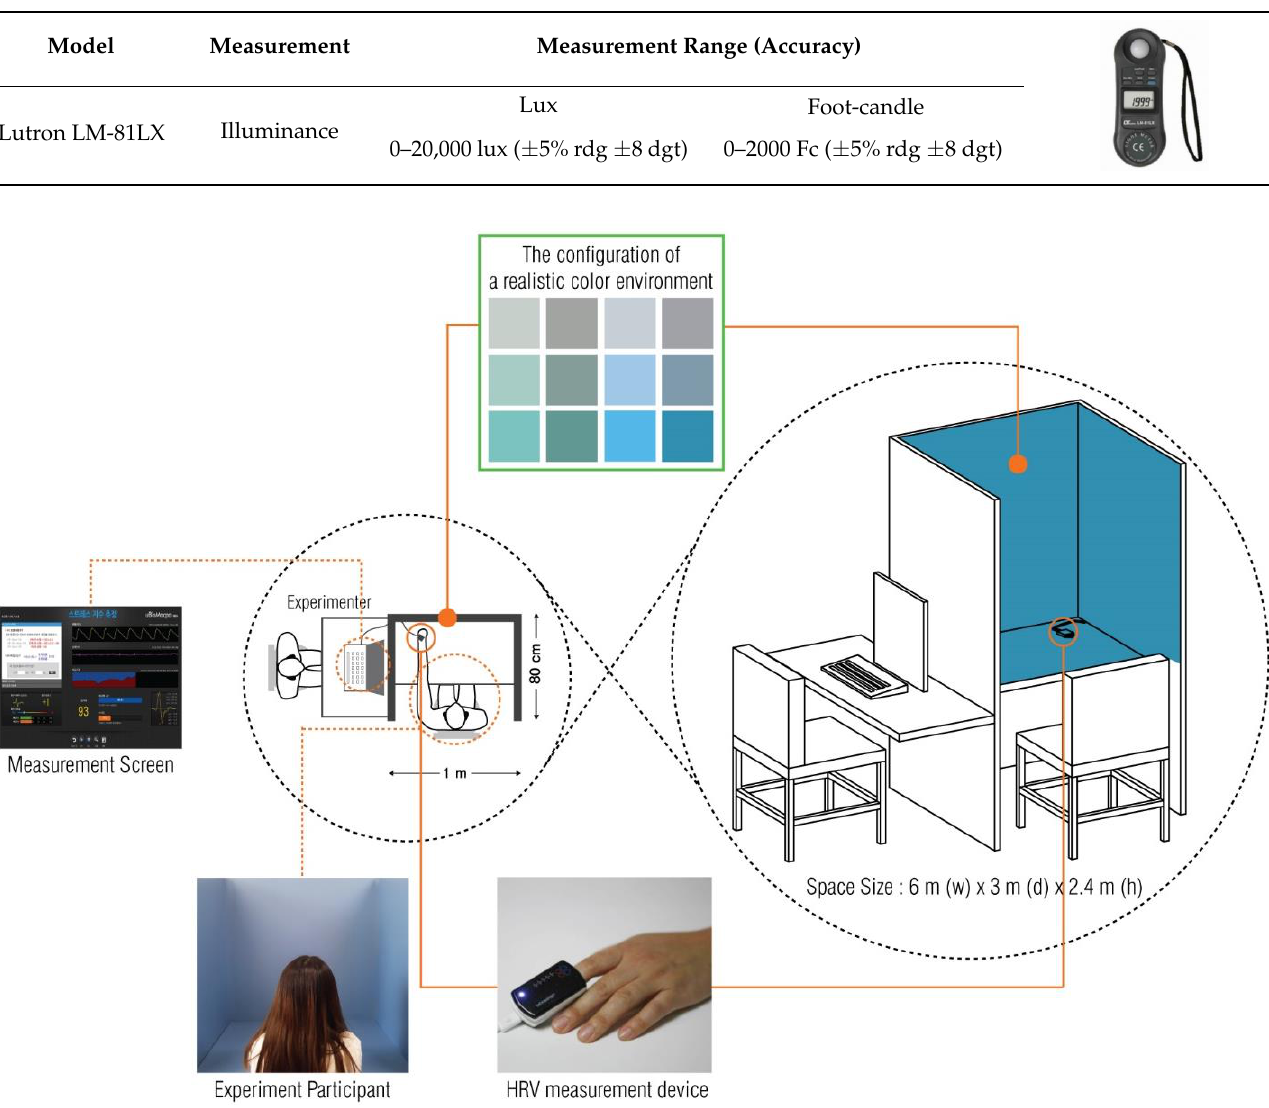
Table 6. Specifications of photometer (Luton LM-81LX).